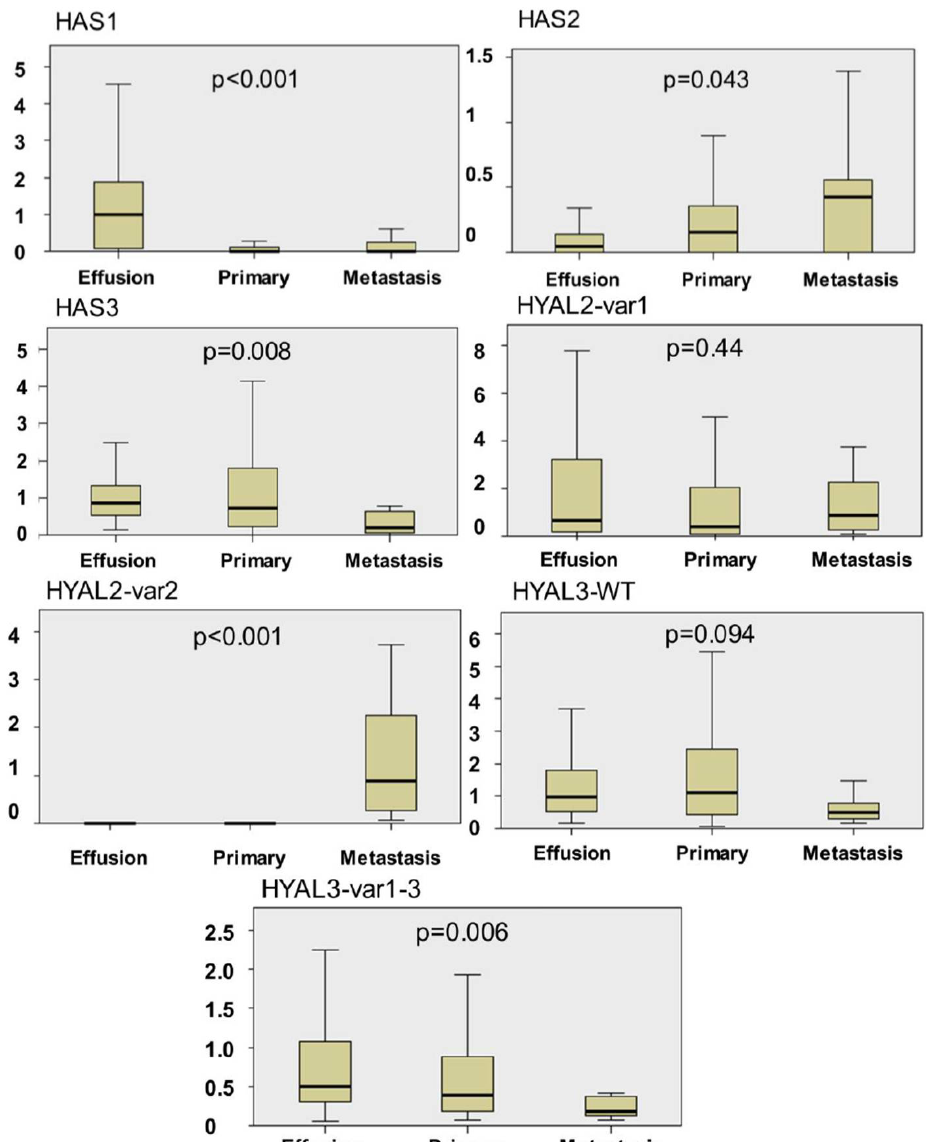
Figure 2. Anatomic site-related differences in HAS and HYAL mRNA expression. Graphic illustration of the differences in HAS1-3 and HYAL2 mRNA expression between ovarian carcinoma effusions, primary ovarian carcinomas and solid metastases. HAS1 mRNA expression is significantly higher expression in effusions compared to the two other anatomic sites ( p < 0.001); HAS2 mRNA levels are higher in solid metastases and primary carcinomas compared to effusions ( p = 0.043); HAS3 mRNA expression levels are significantly higher in primary carcinomas and effusions compared to solid metastases ( p = 0.008); HYAL2 -var1 expression is comparable in effusions, primary carcinomas and solid metastases ( p = 0.44); HYAL2 -var2 expression is significantly higher in solid metastases compared to effusions and primary carcinomas ( p < 0.001); HYAL3 -WT expression is higher in primary carcinomas and effusions compared to solid metastases, though not significantly ( p = 0.094). HYAL3 -var1-3 expression is significantly higher in primary carcinomas and effusions compared to solid metastases ( p = 0.006). The bars on the Y -axis represent arbitrary